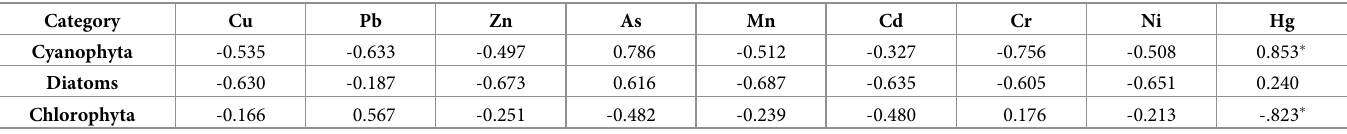
Table 9. Pearson correlation coefficients between the density of photoplankton and heavy metal